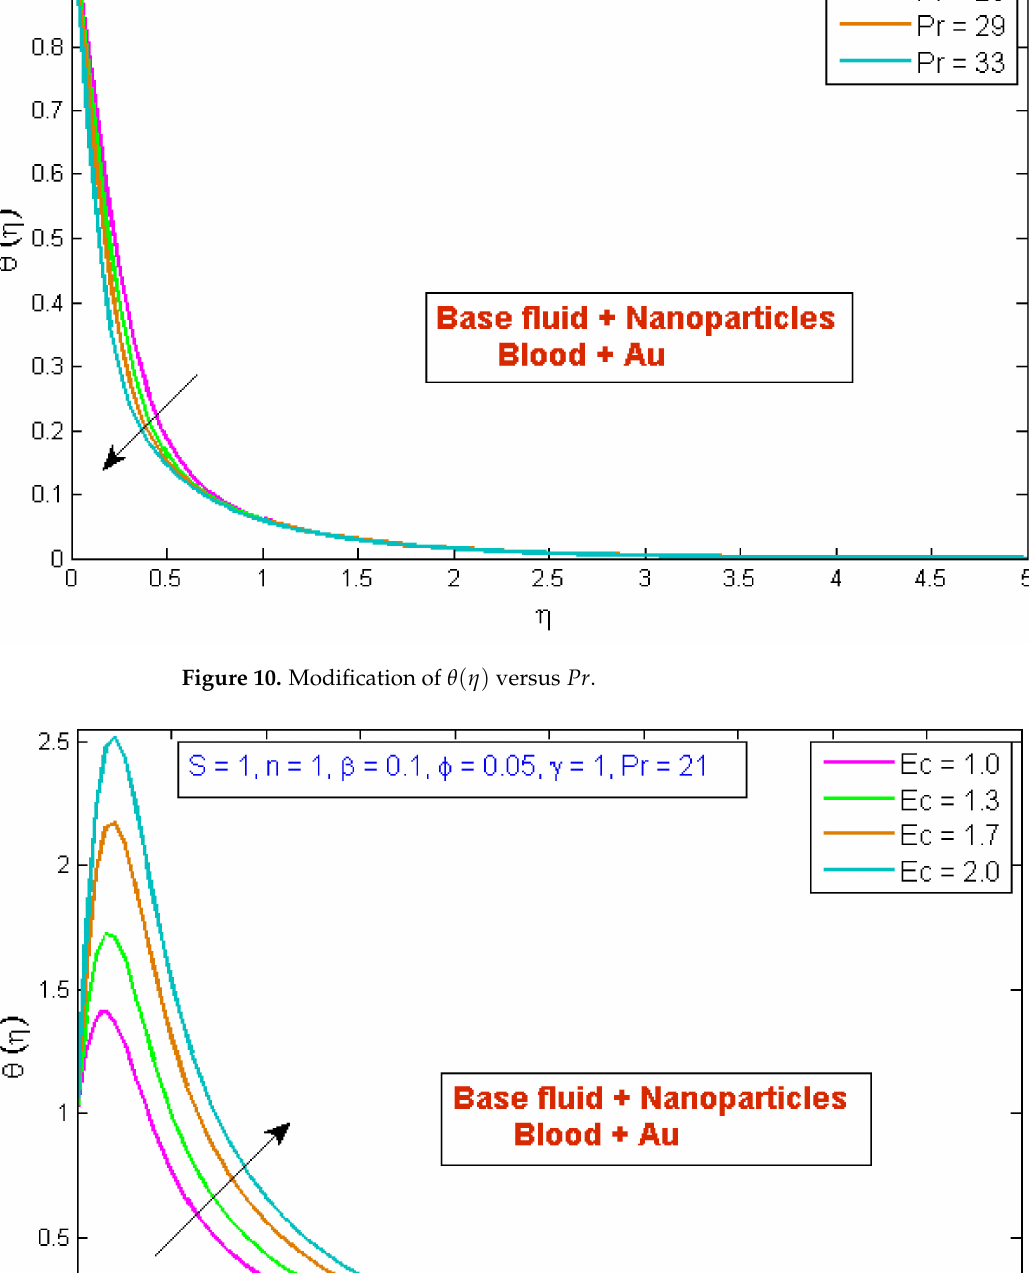
Figure 2 indicates the influence of the volume fraction of gold nanoparticles, φ , on the velocity profile, F (cid:48) ( η ) . The variation was checked on four different values of φ , while